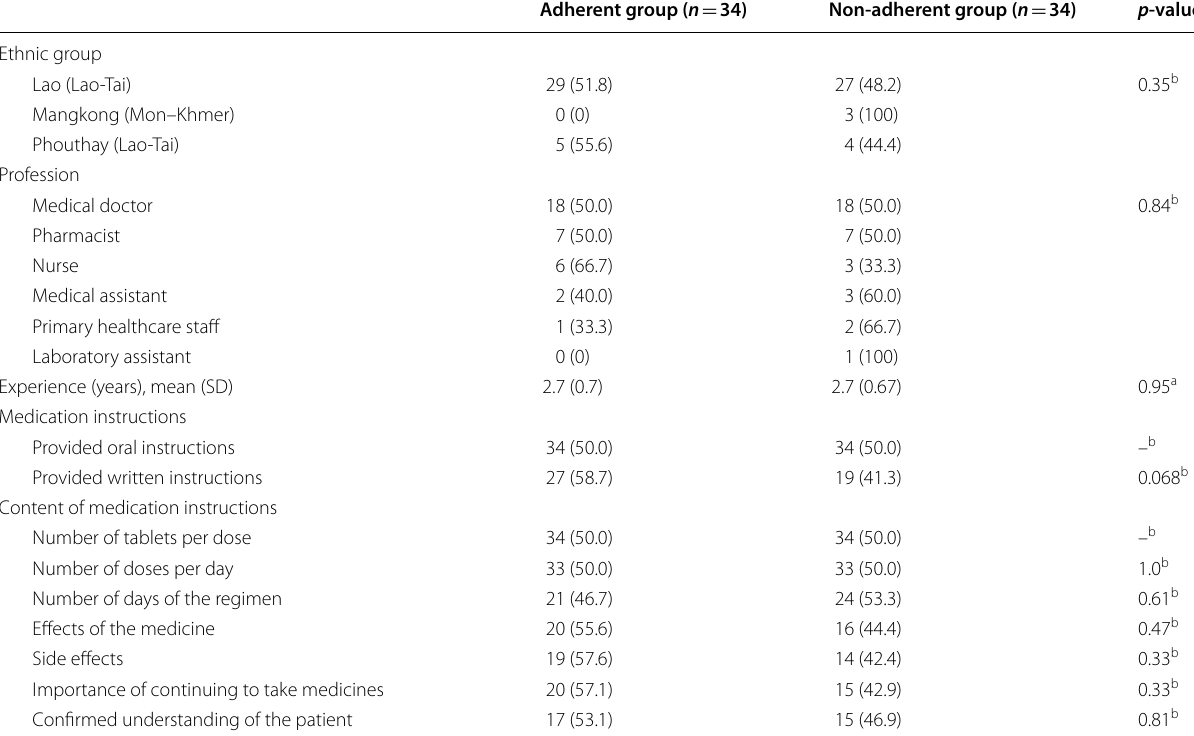
Table 4 Characteristics and practices of the healthcare workers who provided the medication and instructions regarding it for the